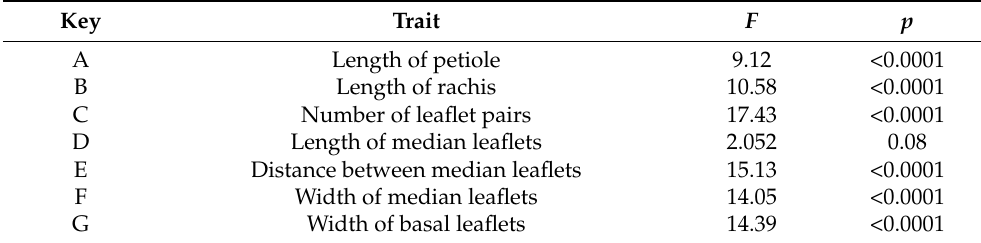
Table 3. Morphometric differentiation of seven traits among the six Ceratozamia species examined. Overall differentiation estimated as Welch’s F in ANOVA and p -values is indicated. Number of samples (adult individuals) per population used in the analyses is indicated in Table